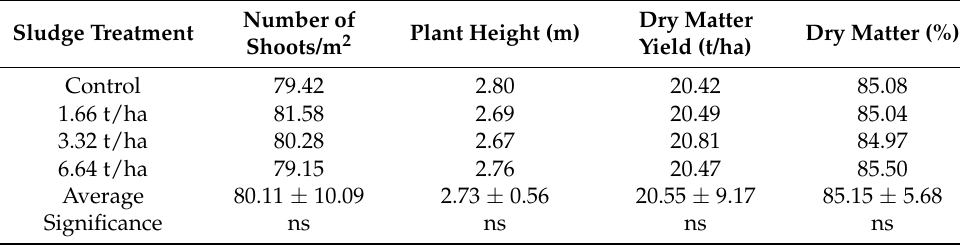
Table 3. Number of shoots, plant height, dry matter yield and dry matter of Miscanthus fertilized with different dosages of municipal sewage sludge. Number of Dry Matter Sludge Treatment Plant Height (m) Dry Matter Shoots/m 2